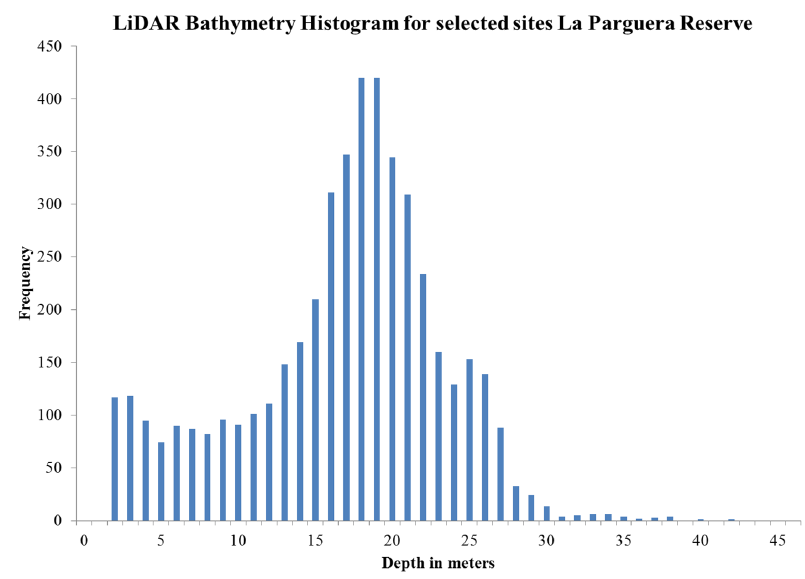
Figure 5. LiDAR SHOALS depth frecuency histogram for the selected points in La Parguera Reserve.